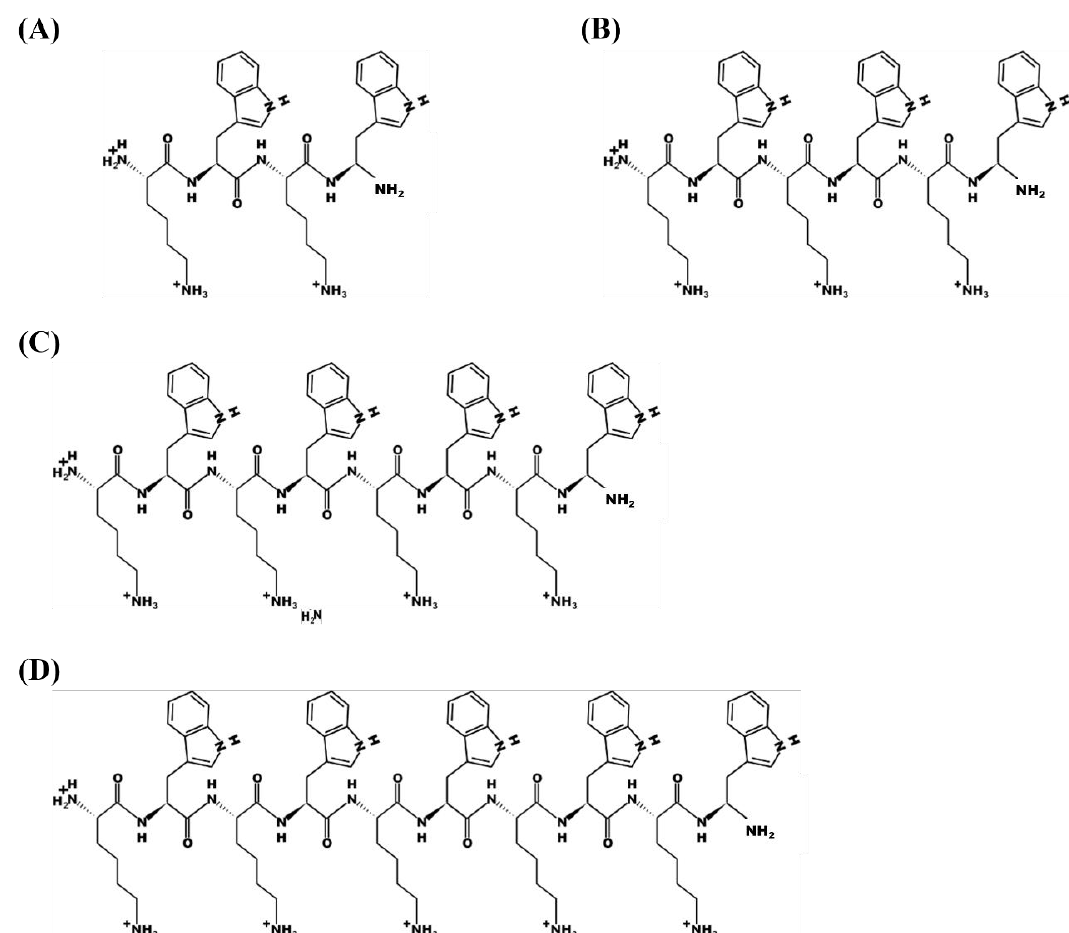
Figure 1. Structures of the peptides used in this study. ( A ) KW 2 , ( B ) KW 3 , ( C ) KW 4 and ( D ) KW